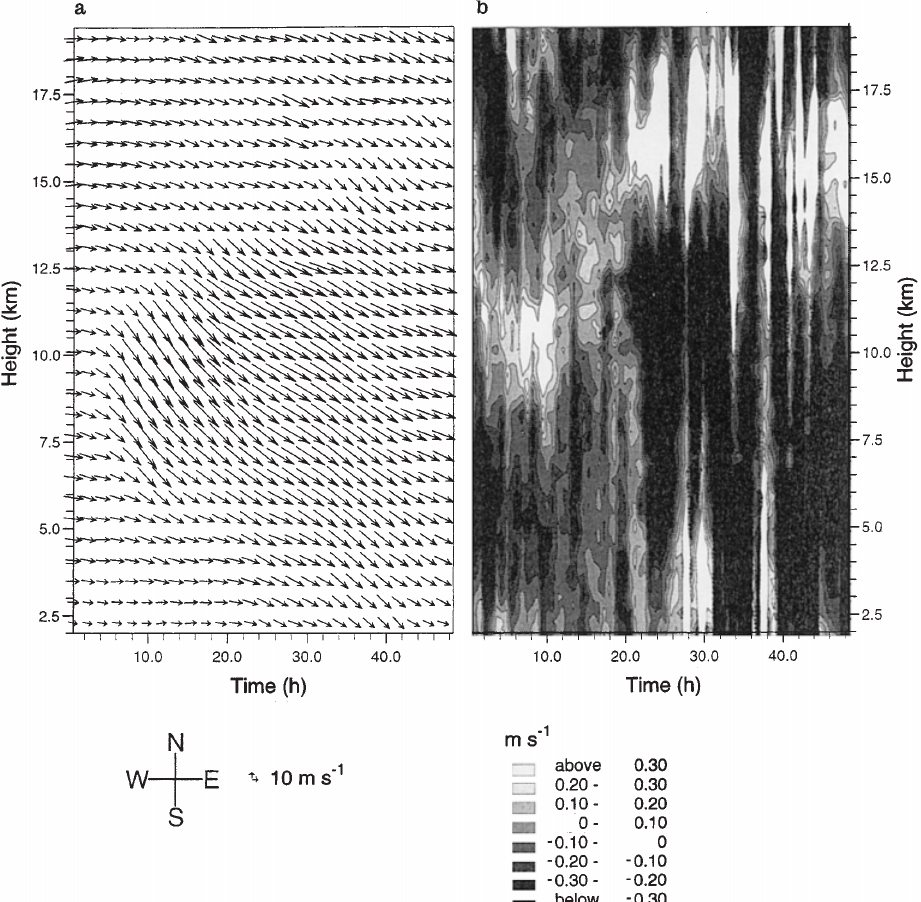
Fig. 1a, b. Height-time plots of a background-wind velocity and b contours of vertical velocity, for 12–13